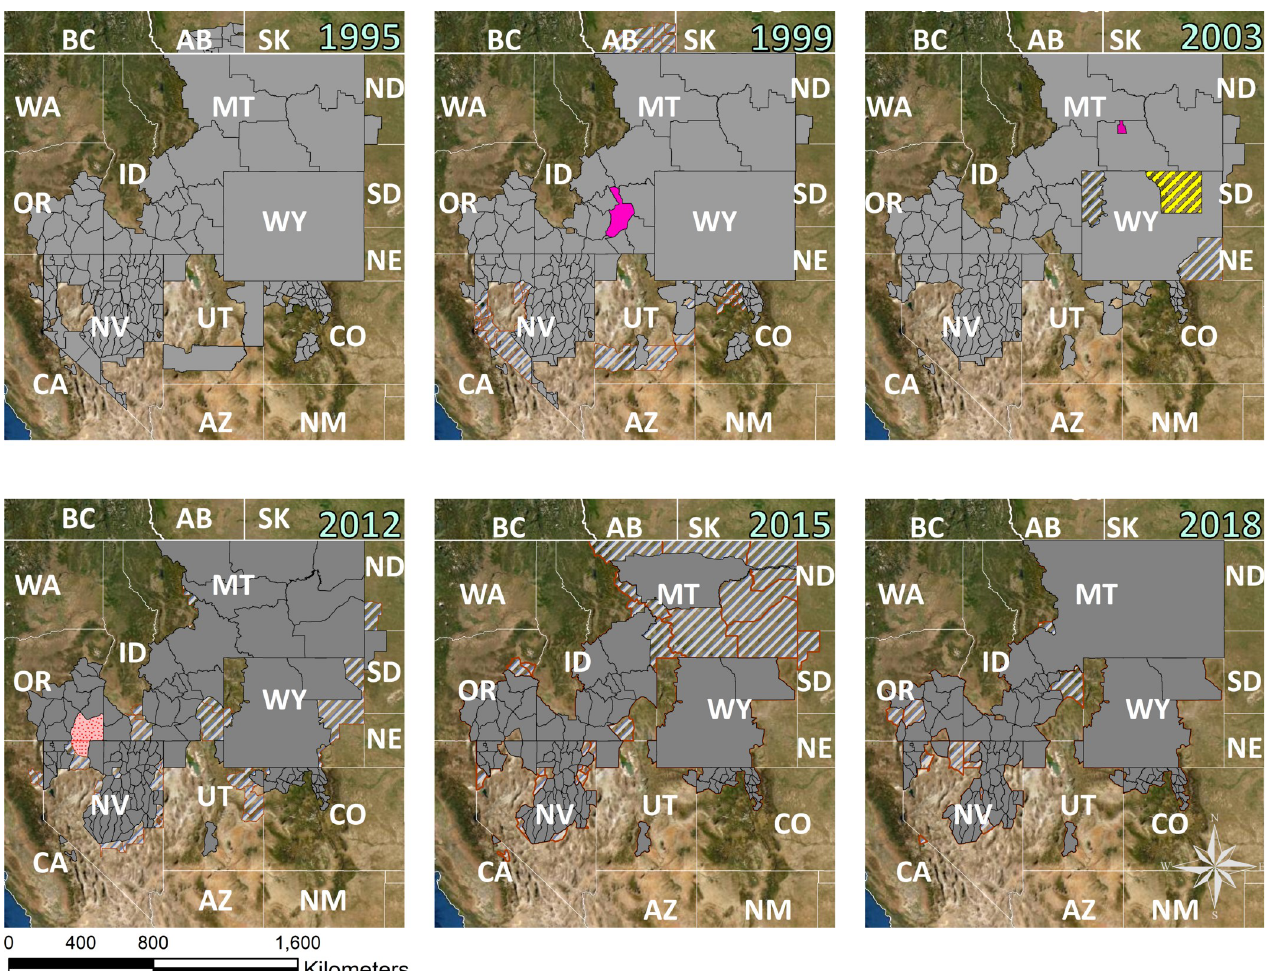
Fig 2. Greater and Gunnison sage-grouse hunt units in the United States and Canada in 1995, 1999, 2003, 2012, 2015, and 2018 within the 1995–2019 study period. Closure types are indicated as follows: small or peripheral populations (grey striped), closures due to federal listing of Gunnison sage grouse (green), experimental closures (pink), closures due to fire (dotted red) and closures related to West Nile Virus (yellow